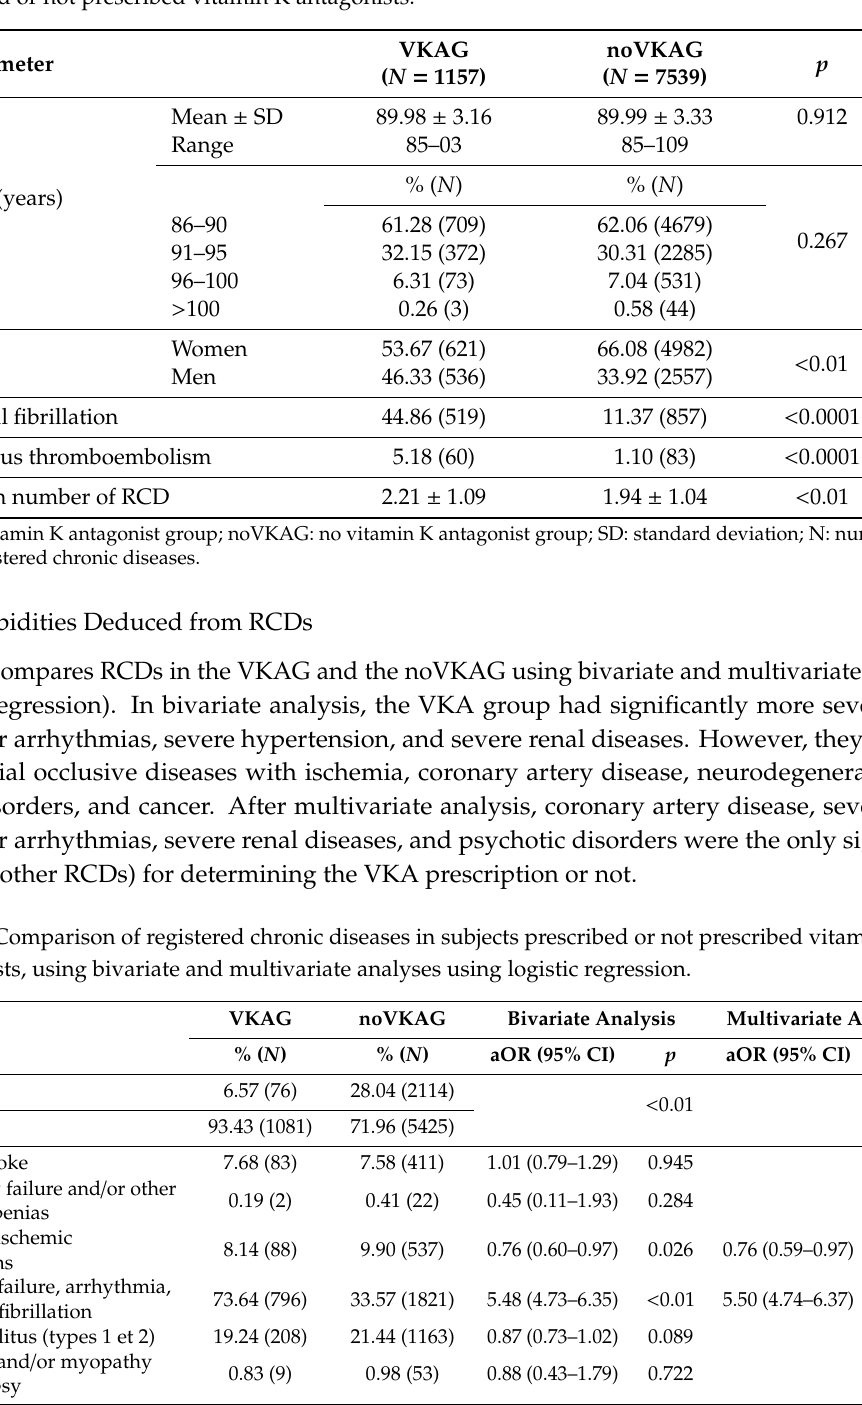
Table 1. Comparison of demographic conditions (age and sex), rates of atrial fibrillation (AF) and venous thromboembolism (VTE), and mean number of registered chronic diseases (RCD) in subjects prescribed or not prescribed vitamin K antagonists.